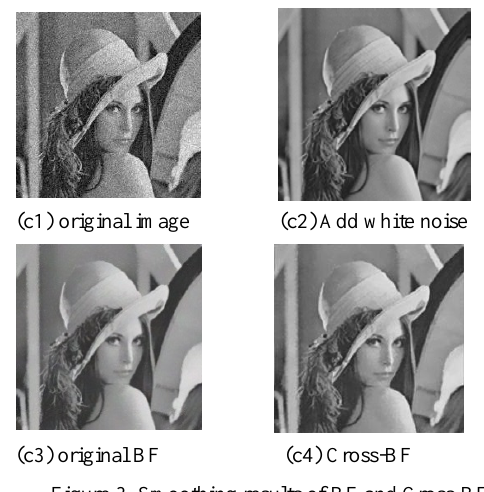
Figure 3. Smoothing results of BF and Cross-BF